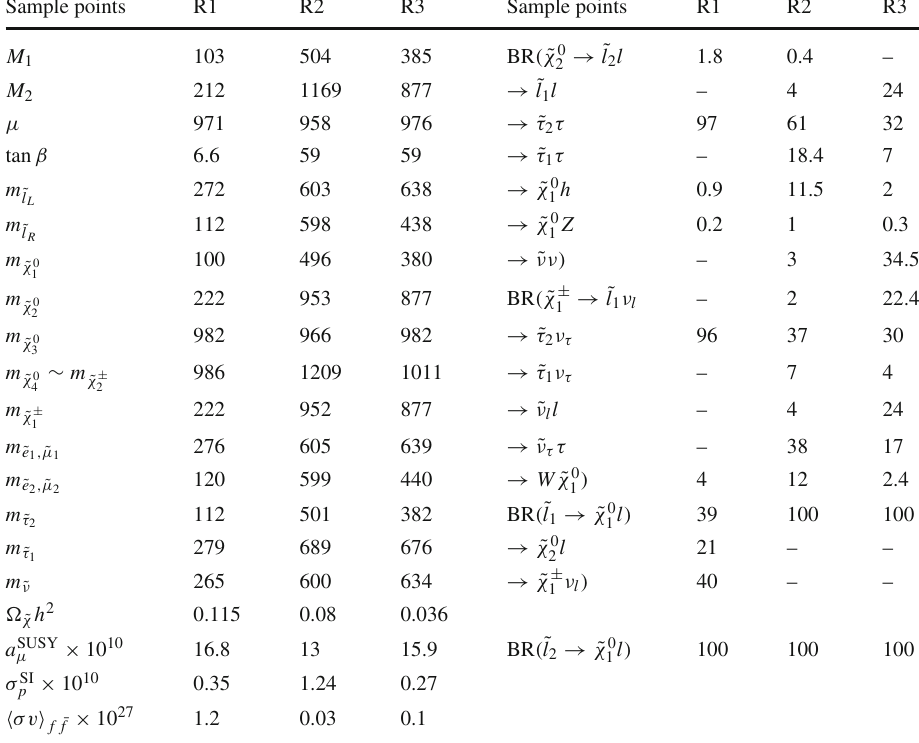
Table 5 The masses (in GeV) and relevant BRs (%) of three points from ˜ l ± -coannihilation scenario Case-R corresponding to the lowest LSP mass, the highest LSP mass with current ( g − 2 ) μ constraints, as well as